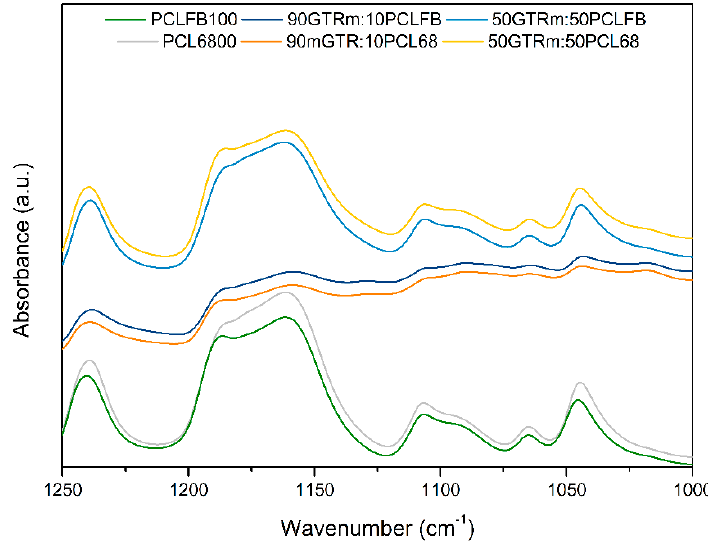
Figure 6. FTIR spectra of analyzed RR/PCL blends in the 1250–1000 cm -1 region.